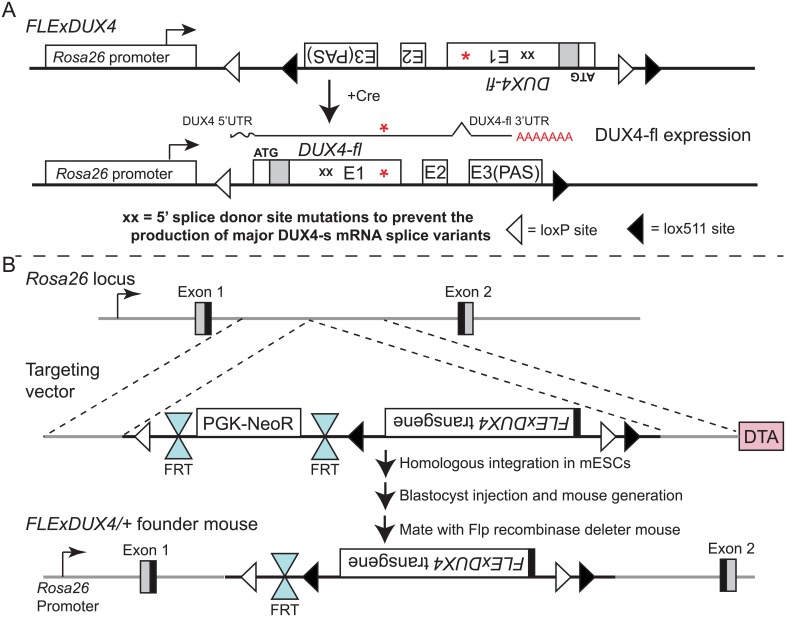
Transgene map and transgenic model generation.(A) The synthesized FLExDUX4 transgene, which maintains the 3 exon and 2 intron structure of the human DUX4 gene, but lacks the DUX4 promoter, was inserted in the antisense orientation to the Rosa26 promoter. The transgene is flanked by heterologous lox sites (loxP and lox511) that unidirectionally recombine in the presence of cre recombinase to invert the FLExDUX4 transgene to the sense orientation. DUX4-fl mRNA is then transcribed from the Rosa26 promoter, processed, and terminated by the DUX4 exon3 PAS. (B) The genome targeting scheme for knocking in to the Rosa26 locus utilized the FLEx system methodology. PGK-NeoR: phosphoglycerate kinase I promoter regulating the neomycin resistance gene. DTA: Diphtheria toxin A gene used for counter selection.